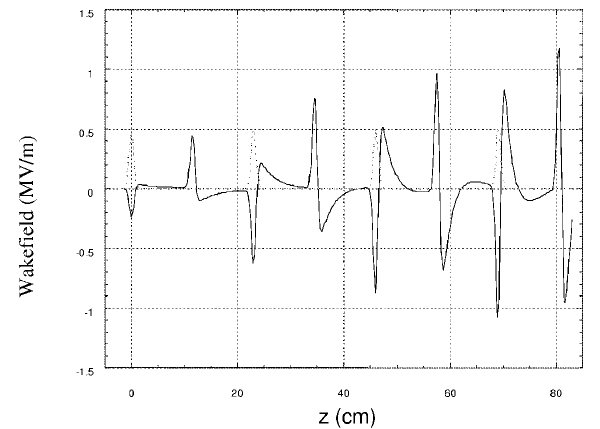
FIG. 7. The wake excited (solid line) by four monochromatic drive beams (charge (cid:1) 4.8 nC each and bunch length (cid:1) 4.5 mm) spaced one wavelength (23.05 cm) apart. The beam distribution is shown as the dashed line and is moving right to left.